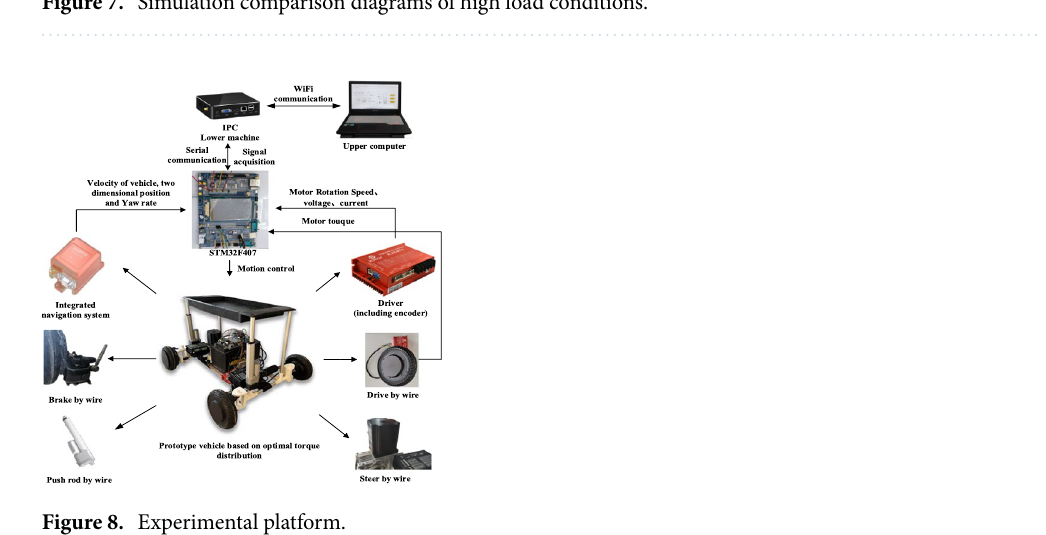
Figure 7. Simulation comparison diagrams of high load conditions.